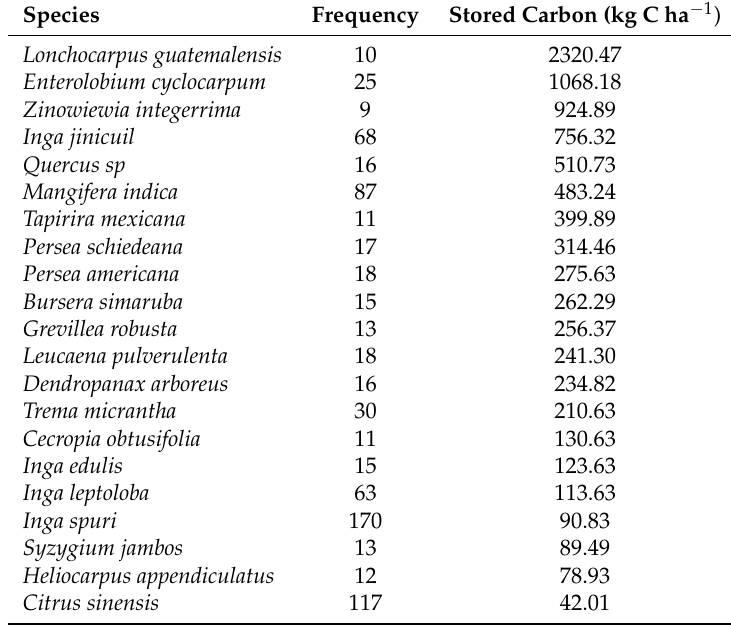
Table 4. Average storage of aboveground C by tree (kg tree − 1 ) of the most common species found in the study region, Veracruz,